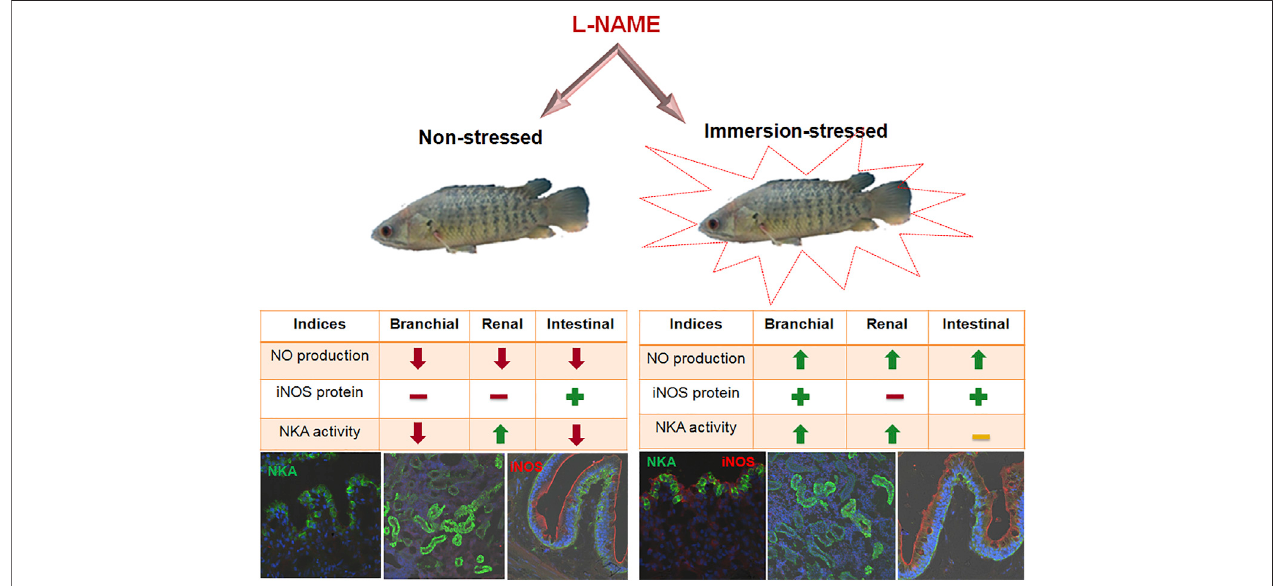
FIGURE 3 | Schematic chart showing the in vivo action of L-NAME on NKA dynamics and the iNOS/NO system in ionocytes of air-breathing fi sh A. testudineus under hypoxemia stress. Treatment of the nitric oxide synthase inhibitor, L-NAME, in non-stressed fi sh suppressed the NO release in the branchial, renal, and intestinal epitheliaofthis fi sh.But,L-NAMEchallengeinhypoxemia-stressed fi shdeliveredmoreendogenousNOproductioninepithelialionocytesduetotheriseininduciblenitric oxide synthase (iNOS) protein abundance, especially in branchial and intestinal epithelia. This activation of the iNOS/NO system in hypoxic fi sh demands multidimensional regulation of NKA in these ionocytes This resistance response of the iNOS/NO system further allows the air-breathing fi sh to restore the compromised epithelial Na + transport and defend against the life-threatening hypoxemia condition (adopted from Peter and Gayathry, 2021).